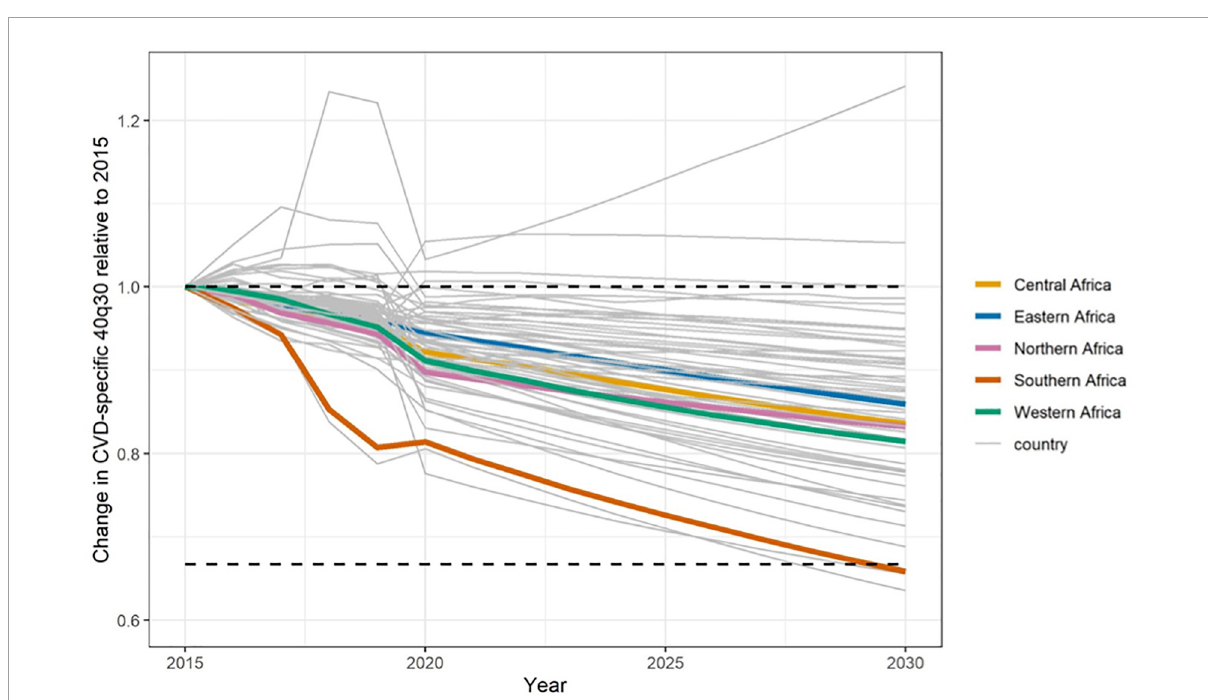
FIGURE6 Status quo projections for 40q30 through 2030 for cardiovascular disease in Africa by country and 5 sub-regions (Southern, Central, Eastern, Western and North Africa). The horizontal lines denote baseline 40q30 in 2015 and a third reduction in 40q30 with respect to 2015 baseline rate